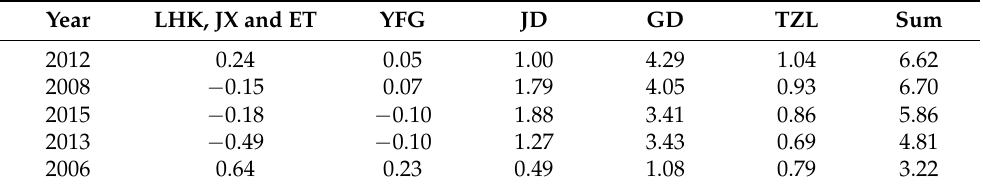
Table 6. Power generation (10 8 kWh) of the Lianghekou Reservoir, Jinxi Reservoir and Ertan Reservoir as well as the daily regulating reservoirs increased by Scheme 3 compared with Scheme